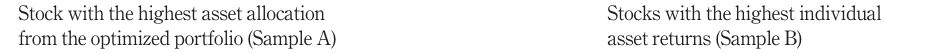
Table 3. Comparison of stocks